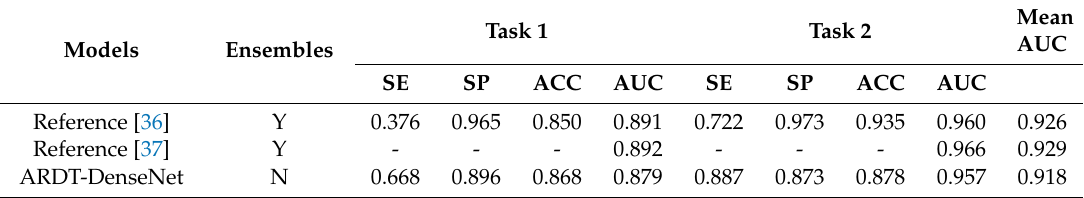
Table 7. ARDT-DenseNet compared with state-of-the-art ensemble learning models in ISIC 2017.